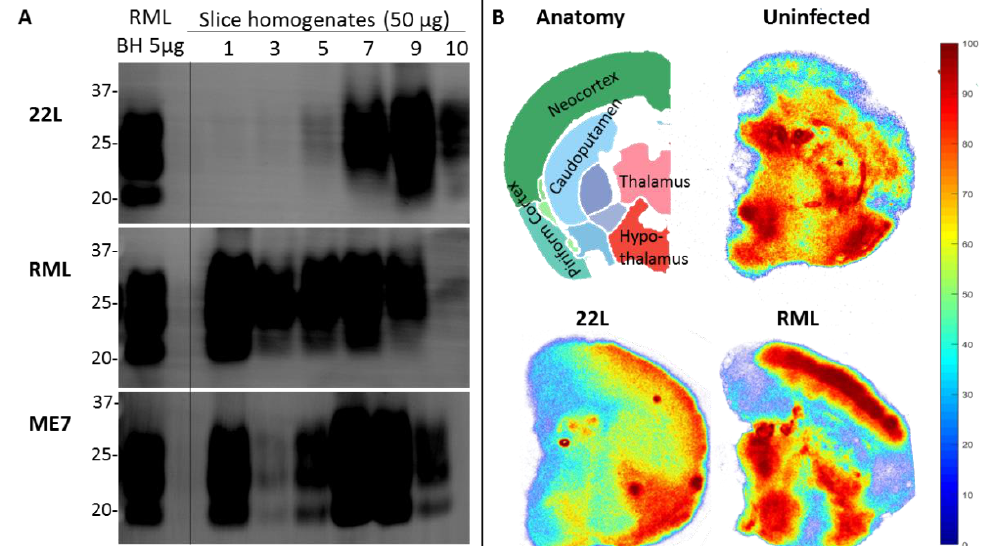
Figure 2. Coronally sliced whole brain prion organotypic slice culture assay (POSCA) can propagate three rodent-adapted scrapie strains. A ) Immunoblots of proteinase K (PK)-digested PrP from slice homogenates of anterior (1) through posterior (10) cultured brain regions. Slices were infected with